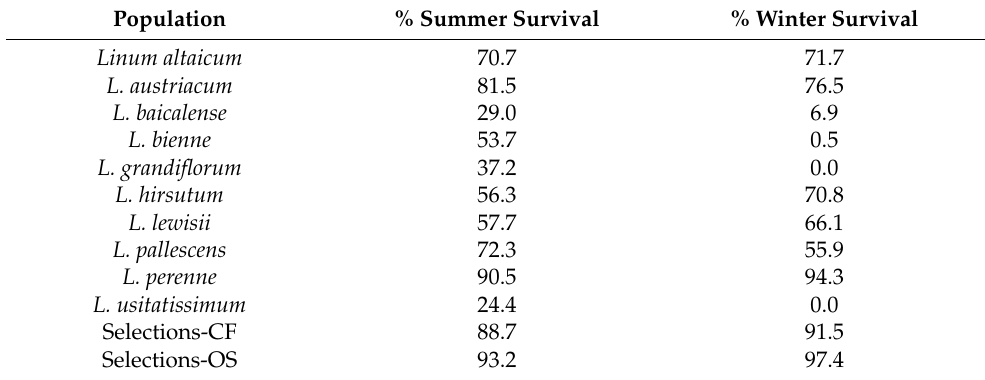
Table 6. Percent summer survival and % winter survival for flax species, CF and OS